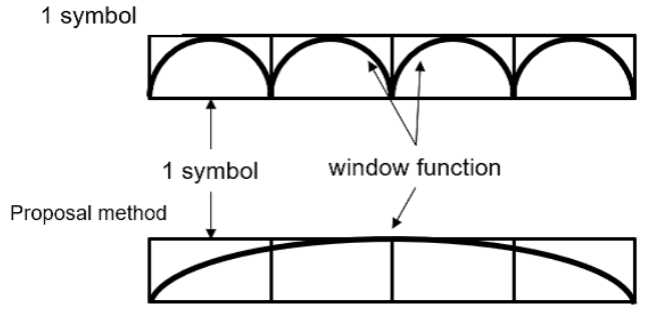
Figure 6. Application of the window